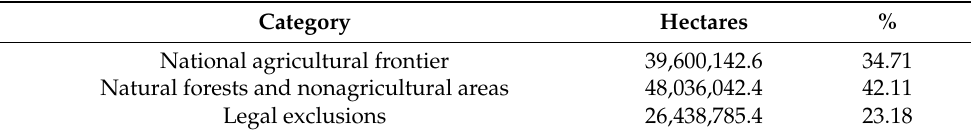
Figure 6. ( a ) Map of the agricultural frontier in Colombia (highlighted in green); ( b ) map of zones of interest for rural, economic, and social development (Zidres) in Colombia (highlighted in purple). Source: [72]. Table 7. Colombia’s agricultural frontier. Source: [72].